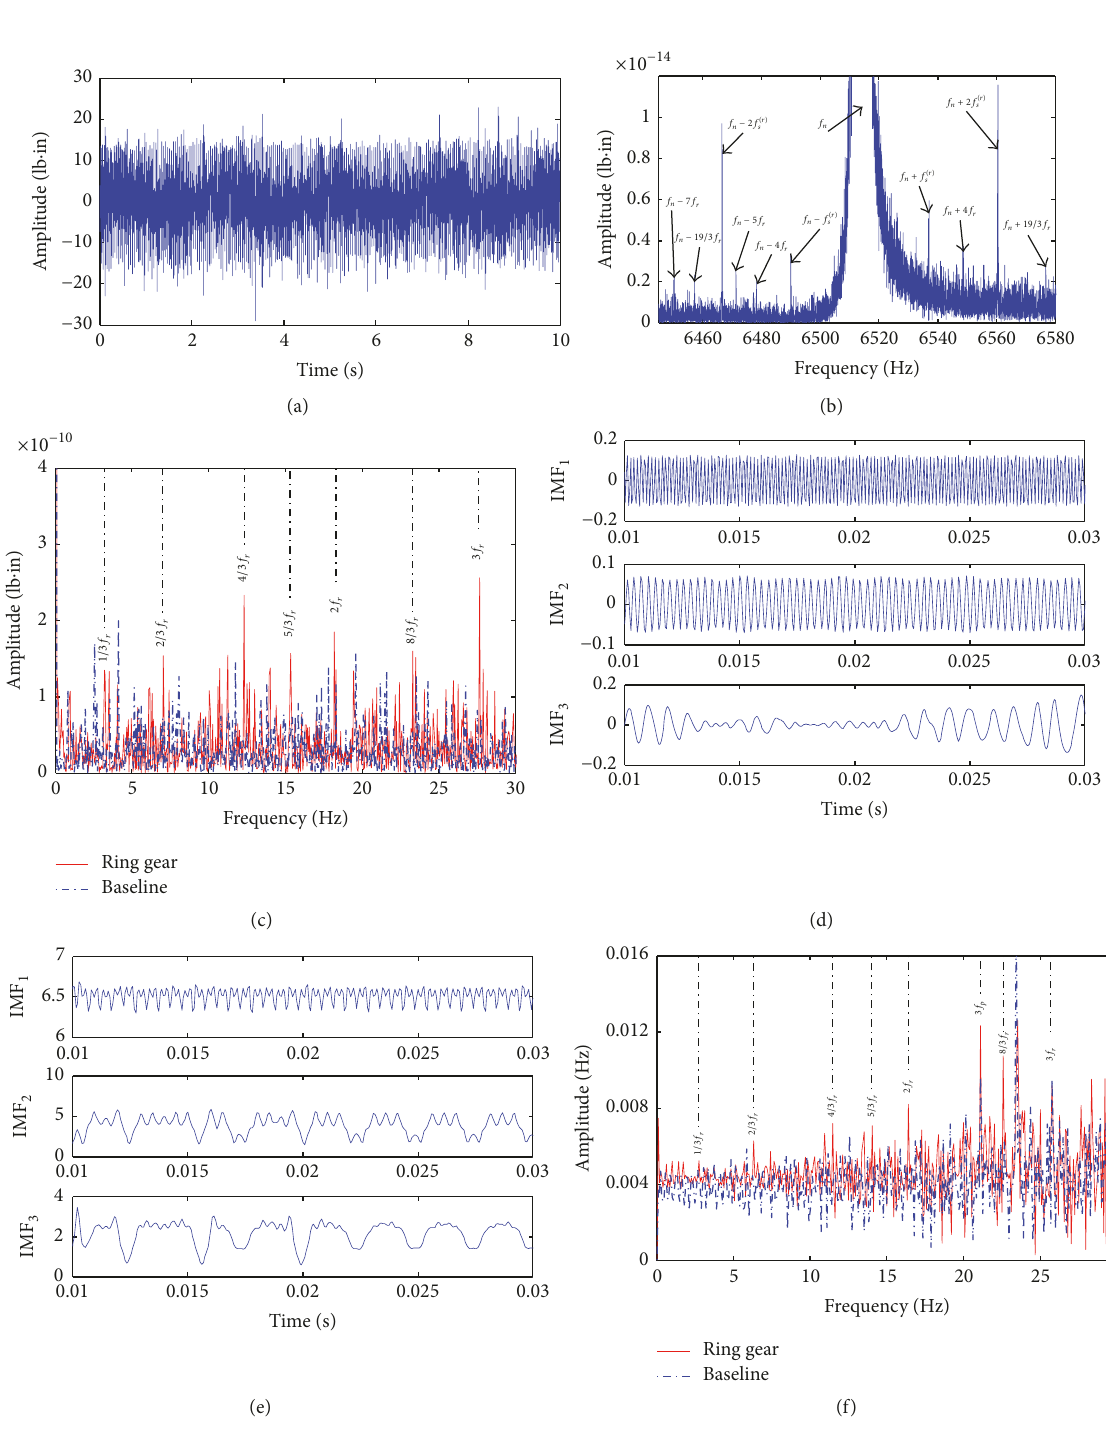
Figure 15: Ring gear fault signal analysis: (a) detrended torsional vibration signal, (b) Fourier spectrum, (c) envelop spectrum, (d) IMFs, (e) instantaneous frequencies of IMFs, and (f) Fourier spectrum of instantaneous